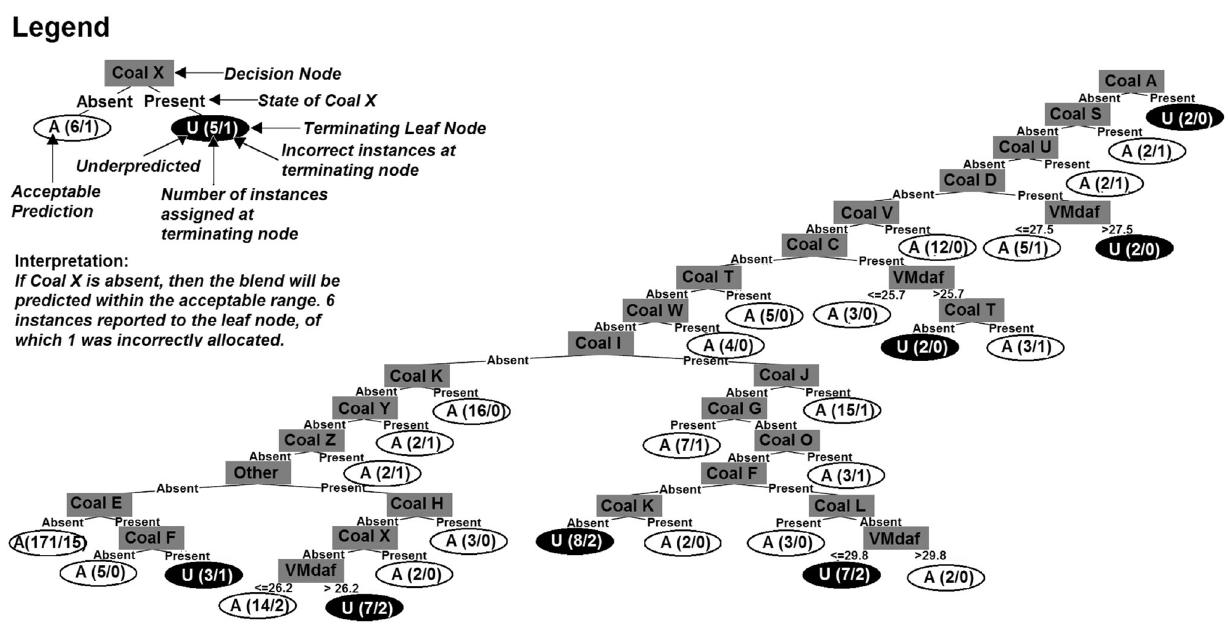
Fig. 11 J48 decision tree for underpredicted blends from the V-group model. Boxes indicate a decision point, whilst ovals are terminal nodes. A white node with black text represents a sample predicted by the original regression model within the RMSE, whilst a black node with white text represents a sample that is underpredicted by the original